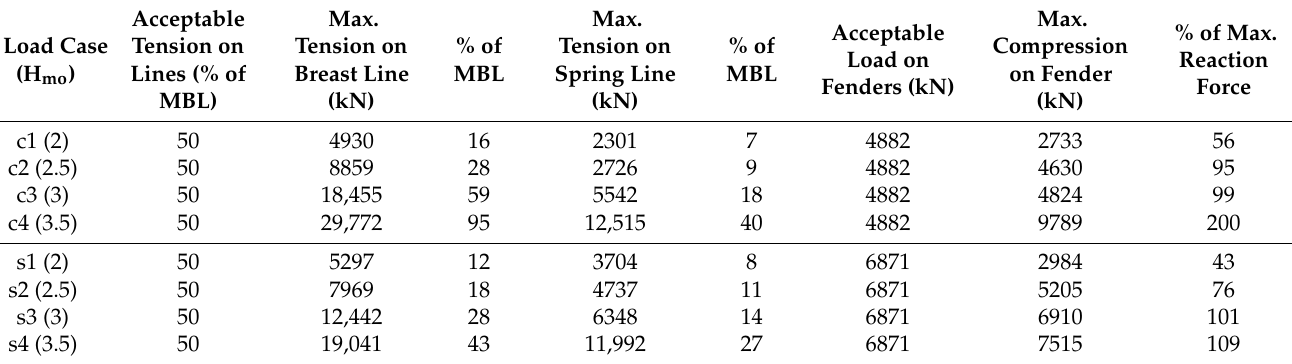
Table 8. Maximal load on the mooring lines and fenders per load